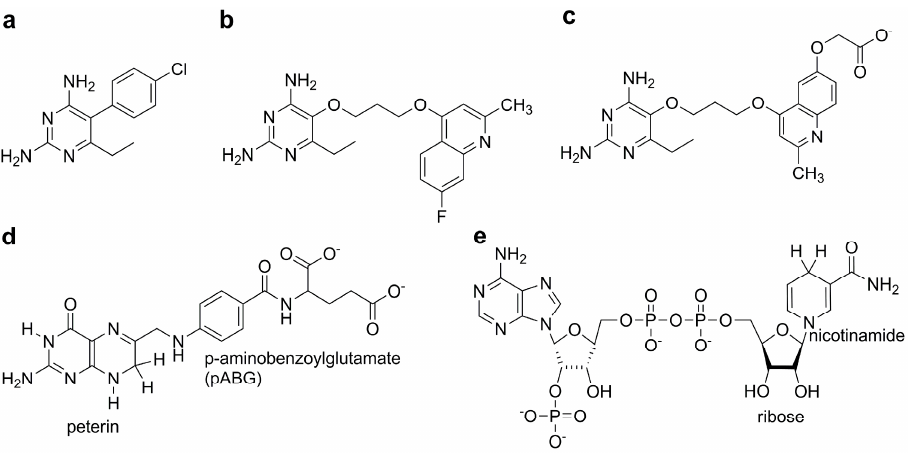
Figure 1. Chemical structures of three compounds; ( a ) P1; ( b ) P157; and ( c ) P169; substrate; ( d ) Dihydrofolate (DHF), and cofactor; ( e ) Dihydrofolate reductase